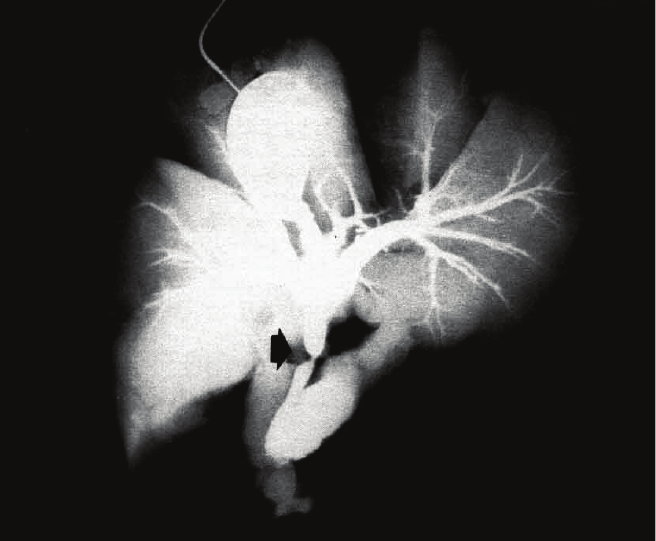
FIGURE 2 - Contrast material filling the duodenum and a small stricture (arrow) of the bile duct are seen.